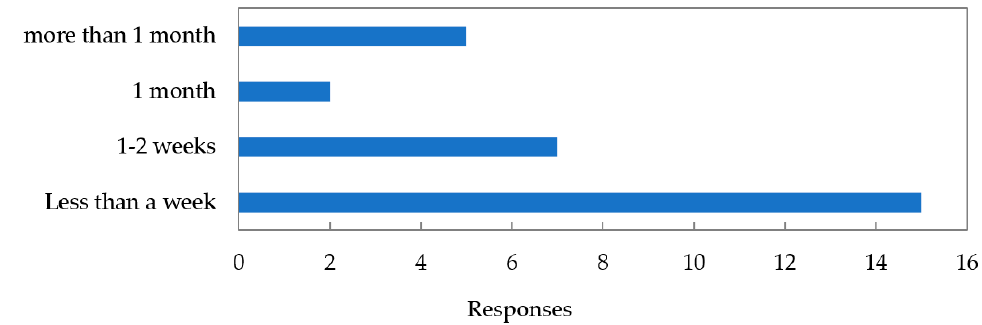
Figure 8. Duration of stope design.